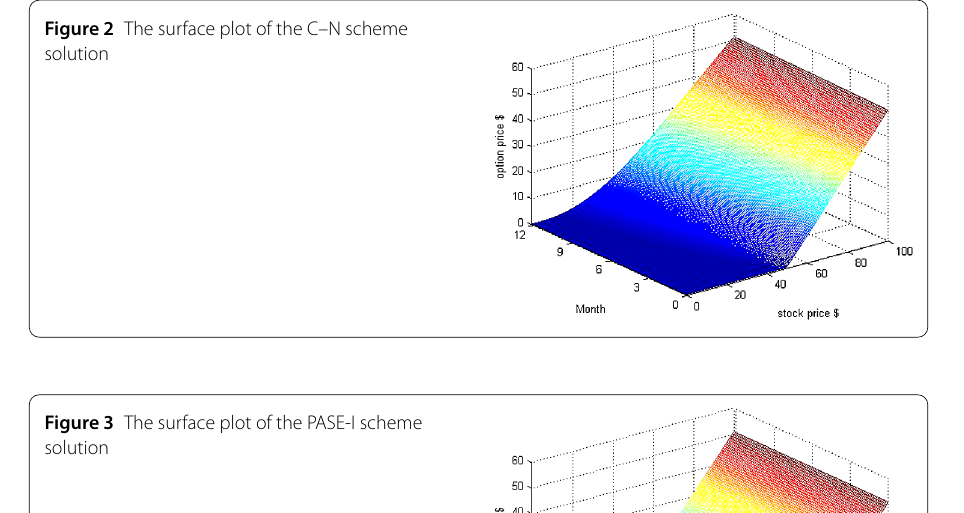
Figure 3 The surface plot of the PASE-I scheme solution